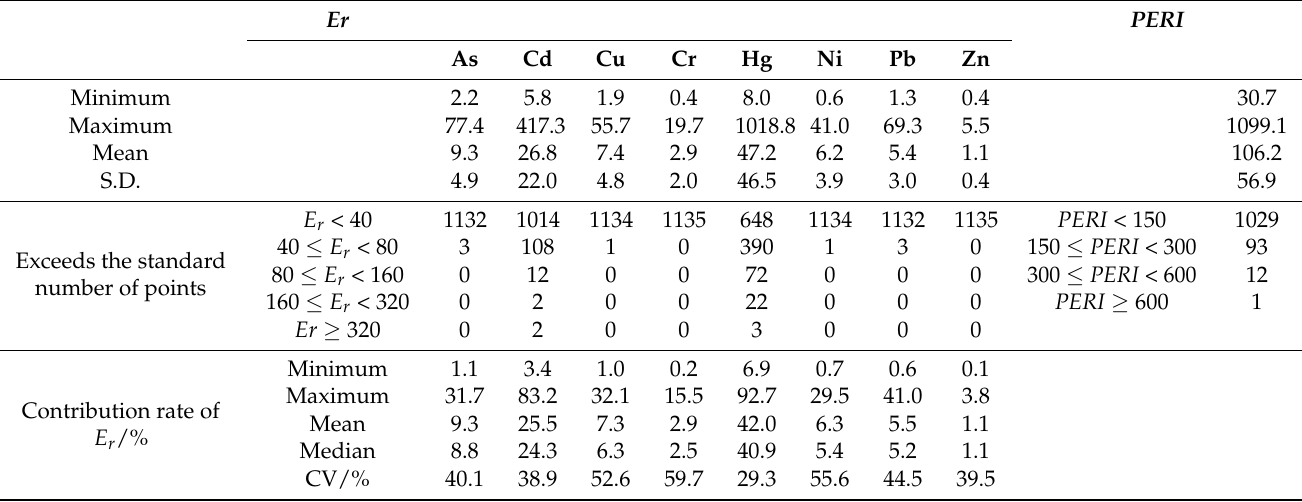
of sites at which values exceeded standard